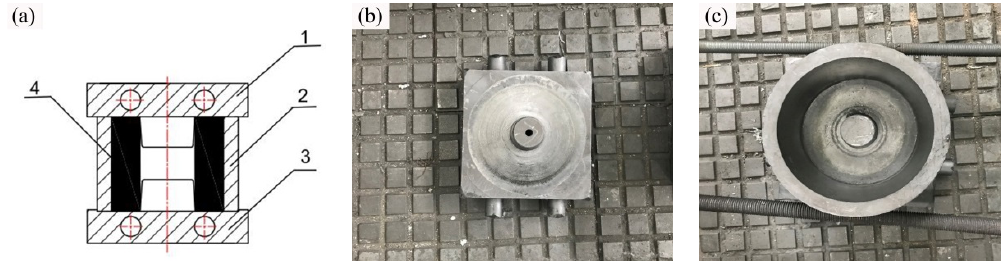
Figure 2. Schematic ( a ) and images ( b ) and ( c ) of the isothermal forging mold; 1—upper plate, 2—lantern ring, 3—lower plate, 4—forging part.